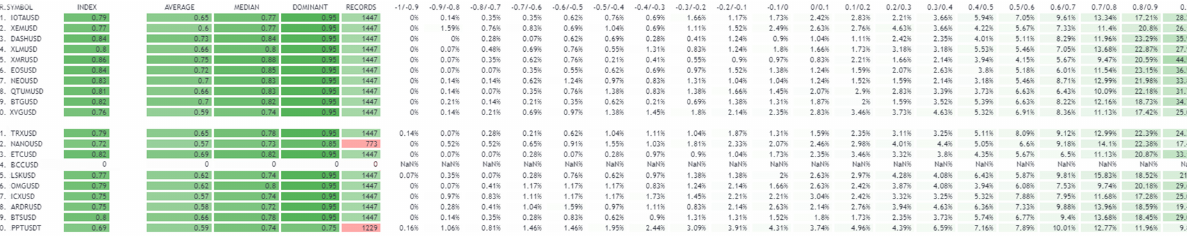
Figure 5. The results of the examination of the correlation between the first 20 altcoins and Bitcoin in TradingView. NaN% means no data was available. Green indicates positive results, white neutral results and red indicates that not full 1462 days of records was available.